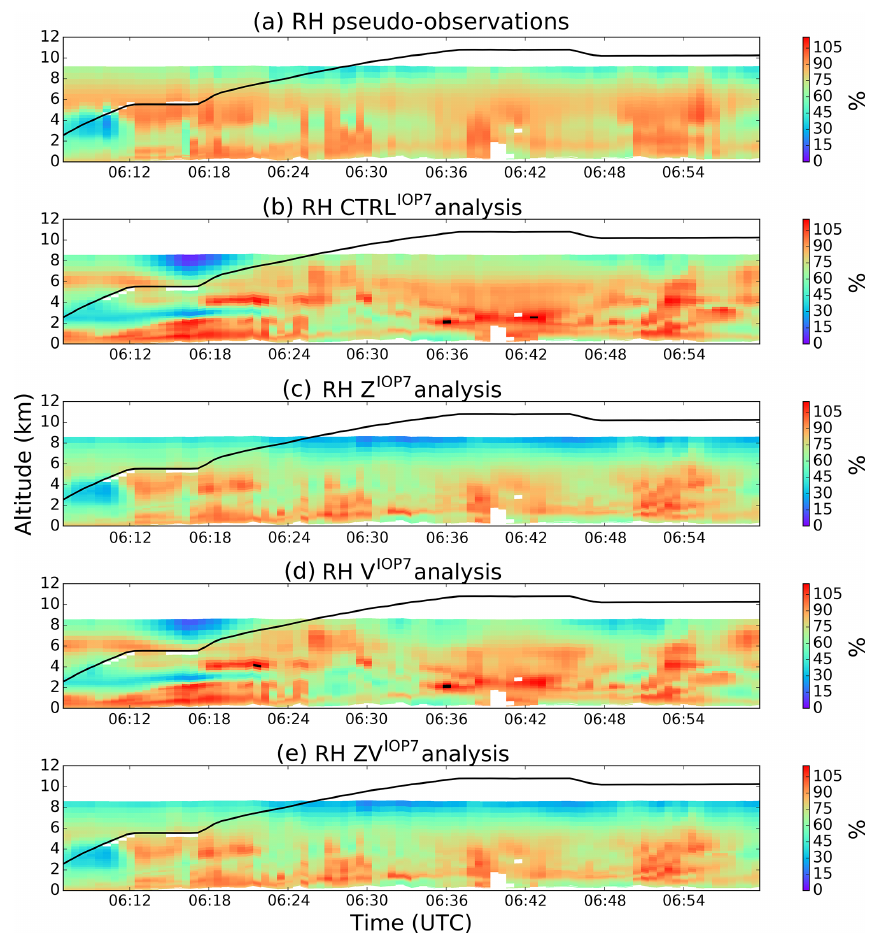
Figure 6. Relative humidity (RH, in %) for (a) – (e) : the pseudo-observations, the CTRL IOP7 , the Z IOP7 , the V IOP7 and the ZV IOP7 experi-